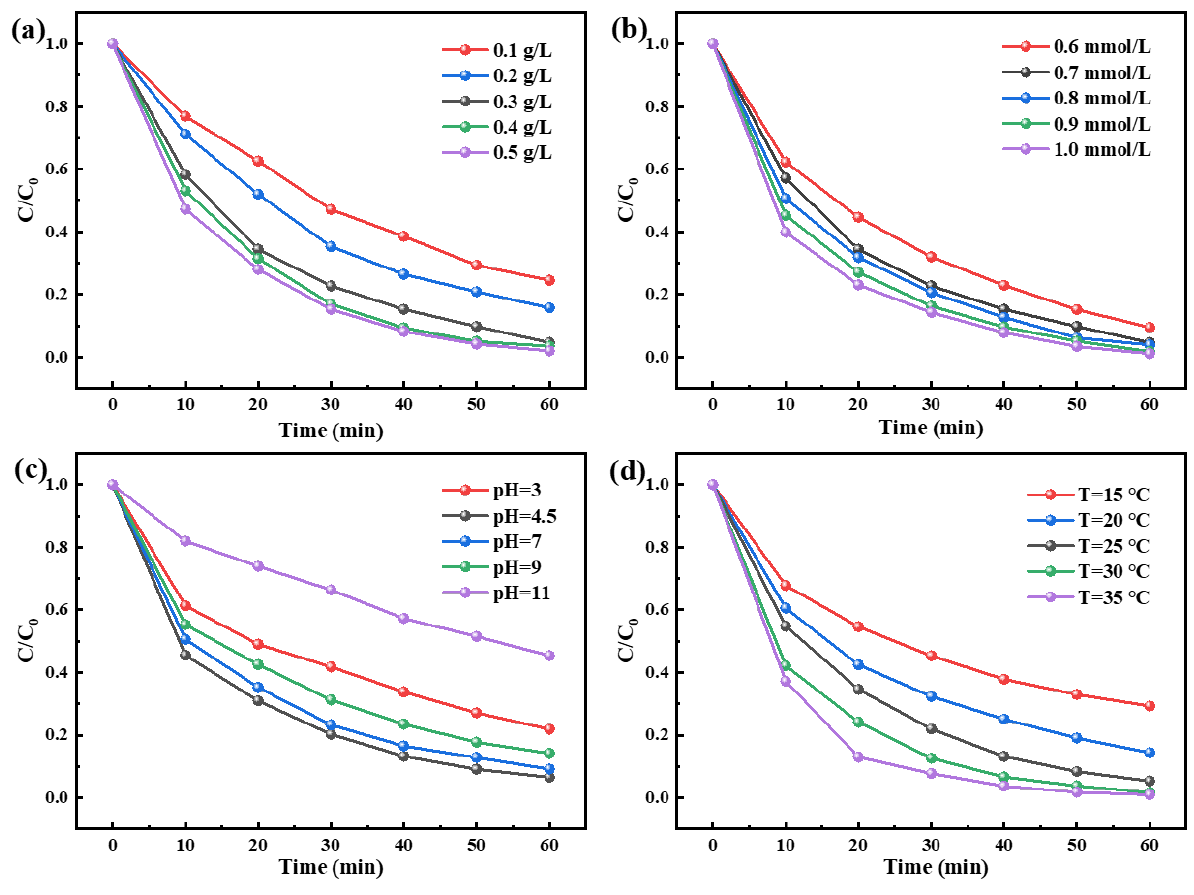
Figure 6. ( a ) The influence of catalyst (Temperature = 25 °C, pH = 4.5, PMS = 0.7 mM, IBU = 10 mg/L); ( b ) The influence of PMS (Temperature = 25 °C, pH = 4.5, catalyst = 0.3 g/L, IBU = 10 mg/L); ( c ) The influence of pH (Temperature = 25 °C, PMS = 0.7 mM, catalyst = 0.3 g/L, IBU = 10 mg/L); ( d ) The influence of temperature (pH = 4.5, PMS = 0.7 mM, catalyst = 0.3 g/L, IBU = 10 mg/L) on the removel of ibuprofen.